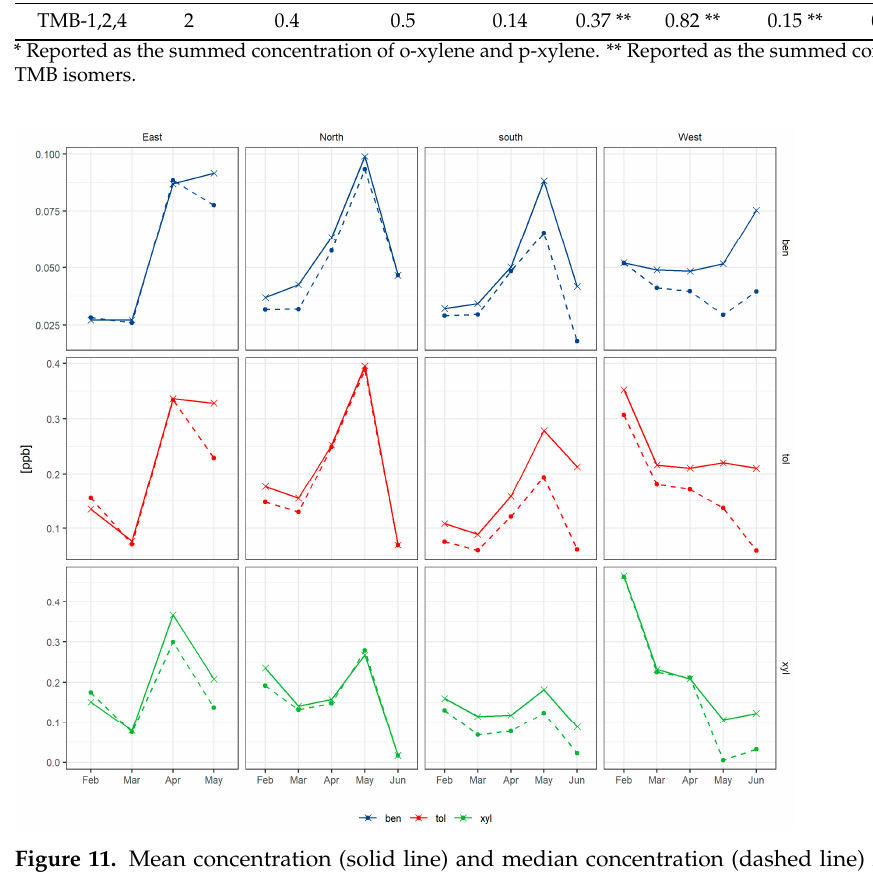
Figure 11. Mean concentration (solid line) and median concentration (dashed line) for benzene, toluene and xylene each month during COALA-JOEYS using only the night data with stable condi- tions. The columns represent the different sectors from the site and the rows are “ben” = benzene; “tol” = toluene and “xyl” =